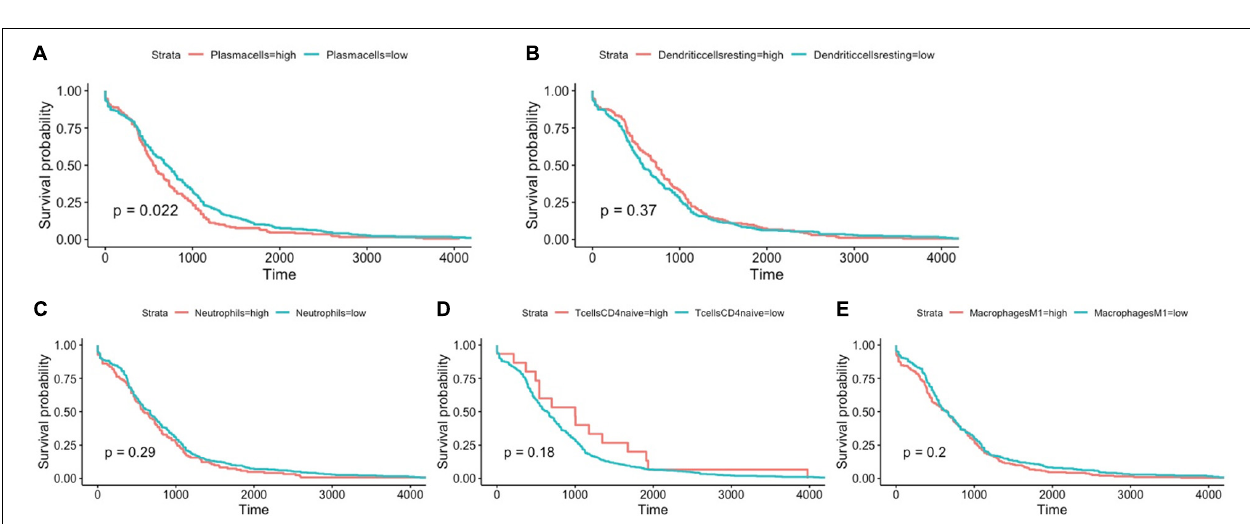
FIGURE 9 | BRAF mutation was correlated with the proportion of immune cells in TCGA (A) and GEO (B) .